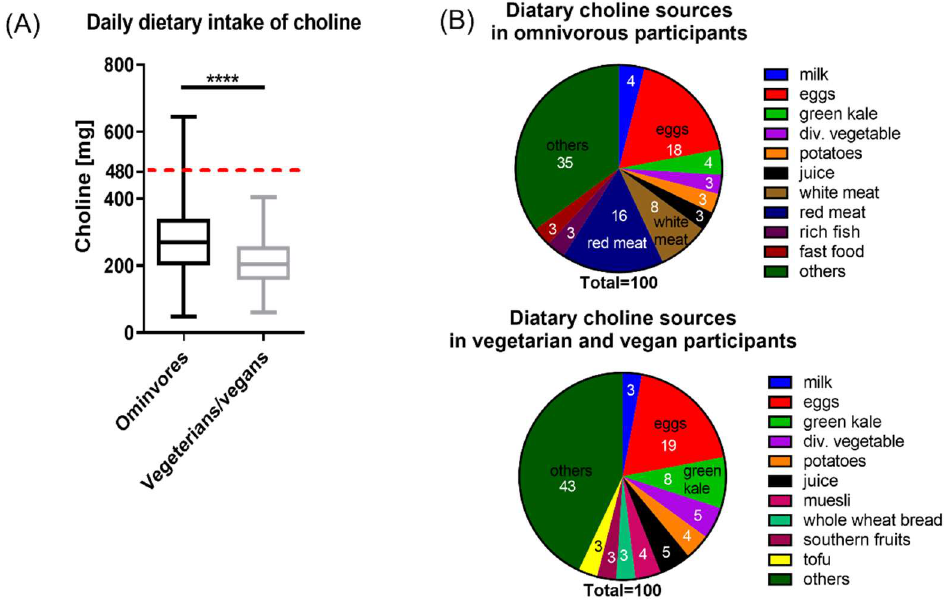
Figure 2. Dietary choline intake. ( A ) Daily dietary choline intake in omnivorous and vegetarian/vegan participants. The AI of 480 mg/day is represented by the red dotted line. Data are presented as median with whiskers from ‘min to max’ and was analyzed with Mann–Whitney test (**** p < 0.0001). ( B ) Dietary choline sources in omnivorous and vegetarian/vegan participants. Data are shown as parts of 100, numbers in the graph indicate the mean contribution of the given food to the total dietary choline intake.